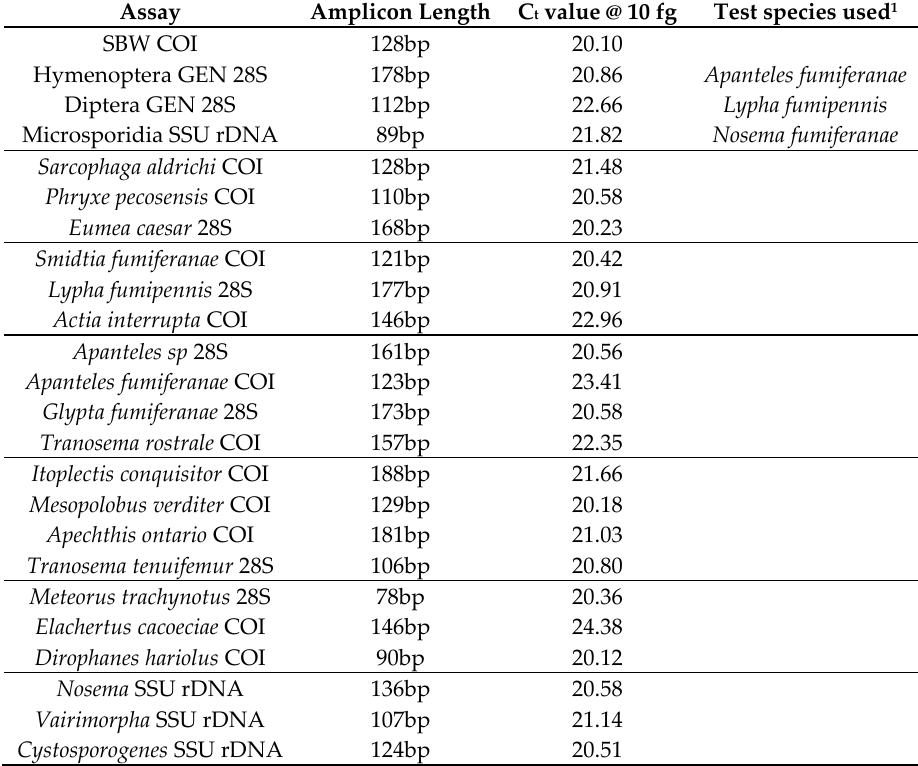
Table 3. C t values obtained for each of the 24 individual assays that make up the molecular sorting tool, using gBlocks ® positive